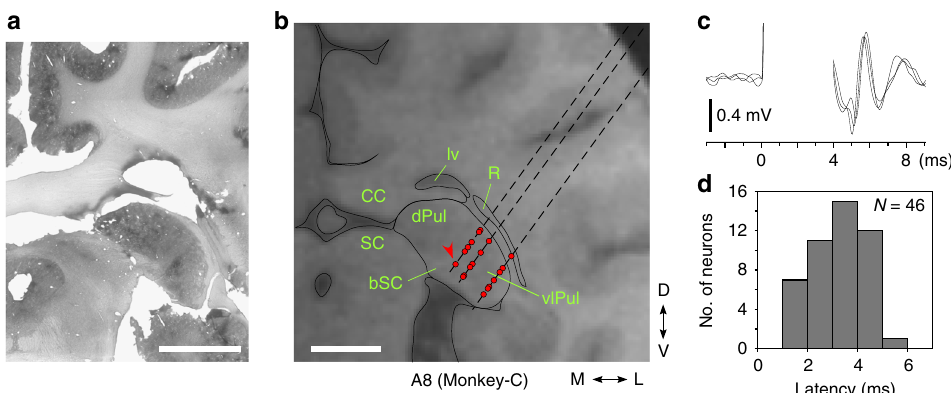
Fig. 2 Location of the Pul neurons activated by the microstimulation of the SC. a Nissl-stained section corresponded to the MRI section shown in b . b The location of neurons (red dot), which showed presumably mono-synaptic responses to the microstimulation of the super fi cial layer of SC (see Methods and Supplementary Figure 6). Red arrowhead indicates the location of neuron shown in c . vlPul: ventrolateral pulvinar. dPul: dorsal pulvinar. bSC: brachium of superior colliculus. R: thalamic reticular nucleus. lv: lateral ventricle. CC: corpus callosum. A8: 8 mm anterior from the ear bar. Dashed line indicates electrode track (see Supplementary Figure 6). Scale bar: 5 mm. c Representative evoked spikes of the Pul neuron (arrowhead in b ). Three consecutive traces are superimposed. The evoked spikes showed short latency and small jitter. d The distribution of response latencies of neurons, which showed presumably mono-synaptic response, recorded in the ipsilesional vlPul of two